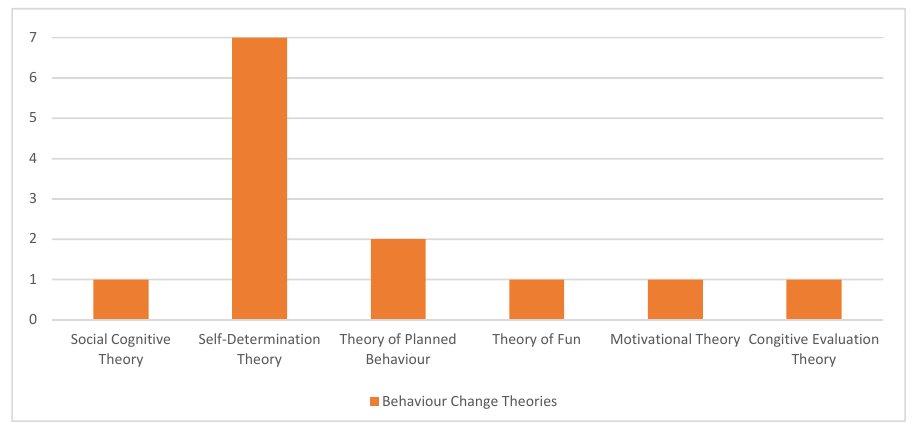
Figure 9 . The frequencies of game features in the Education domain. With regards to behaviour change theories, SDT was the most adopted theory by far, followed by theory of planned behaviours, SCT, theory of fun, motivational theory, and cognitive evaluation theory, as depicted in Figure 10.